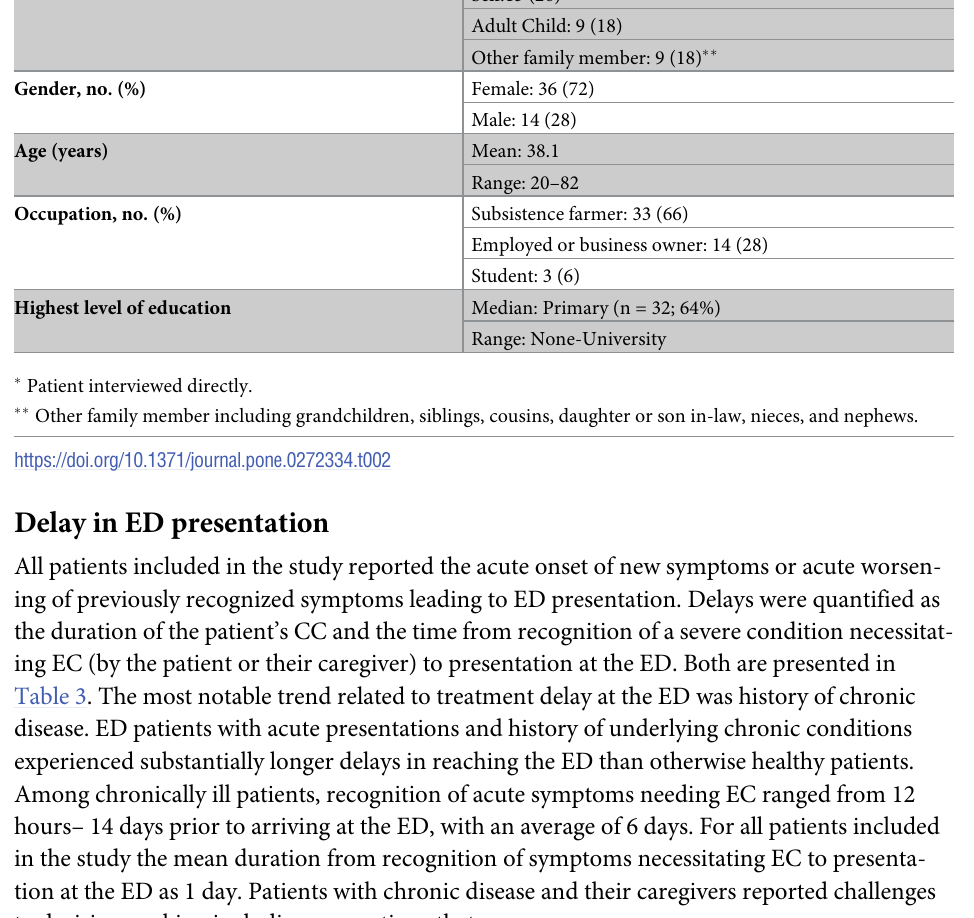
Table 2. Interview participants’ demographic data. Relationship to patient, no. (%)